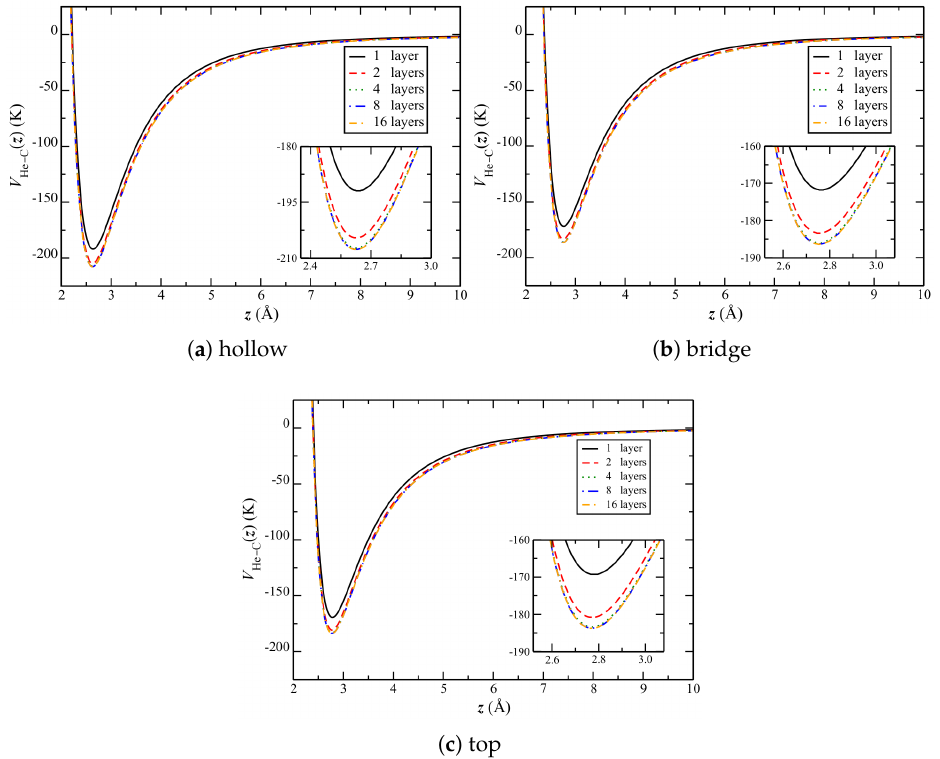
Figure 9. V He–C ( z ) over the three symmetric sites of the top graphene layer (Figure 1b) of graphite. Results are shown for increasing numbers of graphene layers, up to